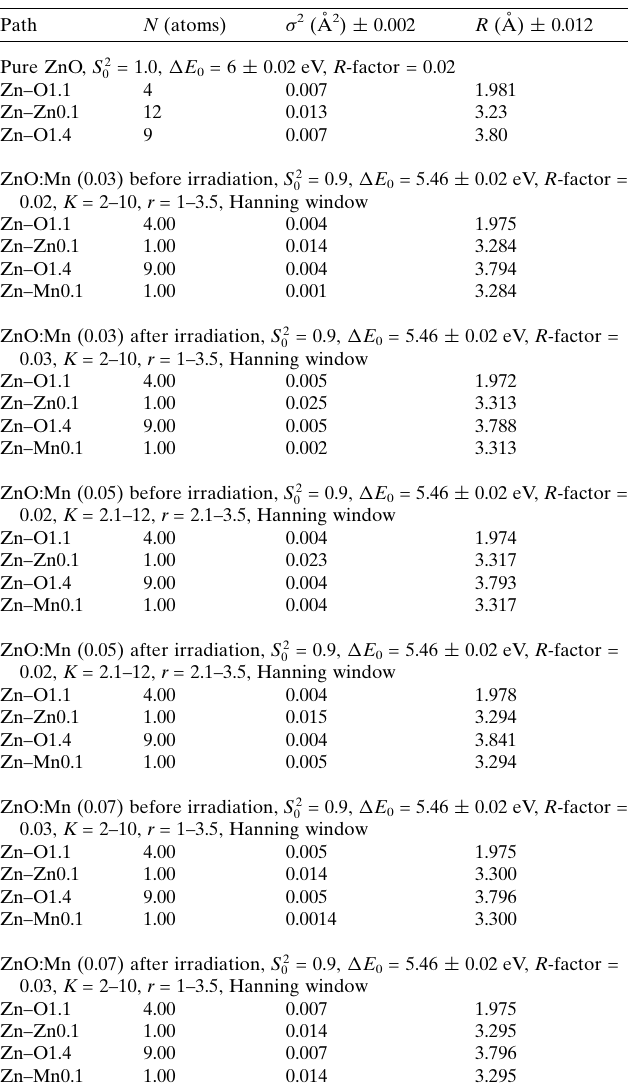
Table 3 The best-fit model parameters of the EXAFS signals showing the compositional dependence of the Mn dopant at different values of x with respect to the pure ZnO for pristine and irradiated samples. Path N (atoms) (cid:3) 2 (A˚ 2 ) (cid:9) 0.002